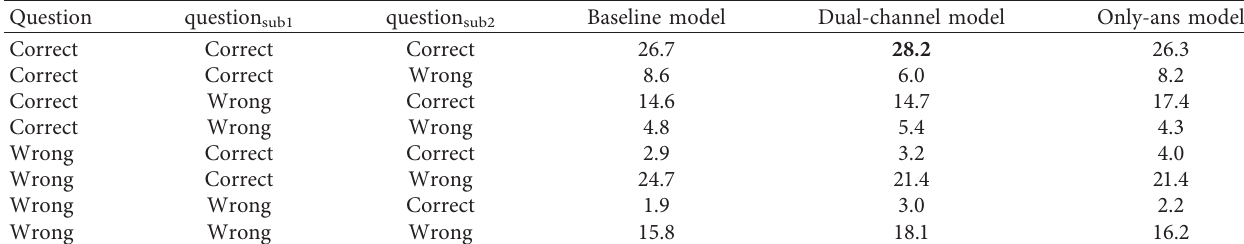
Table 4: Categorical EM statistics (%) of subquestion evaluation for the three models.